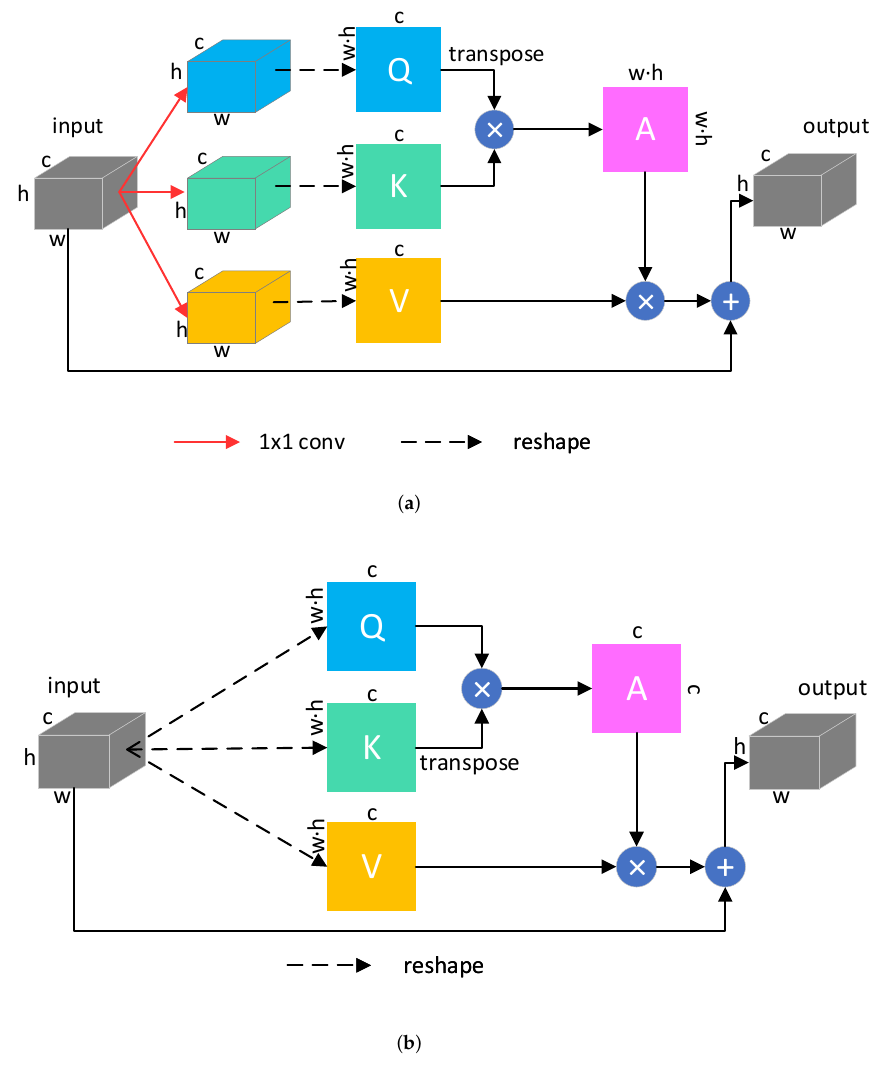
Figure 4. The details of two self-attention modules used in the generator. ( a ) Pixel attention module. ( b ) Channel attention